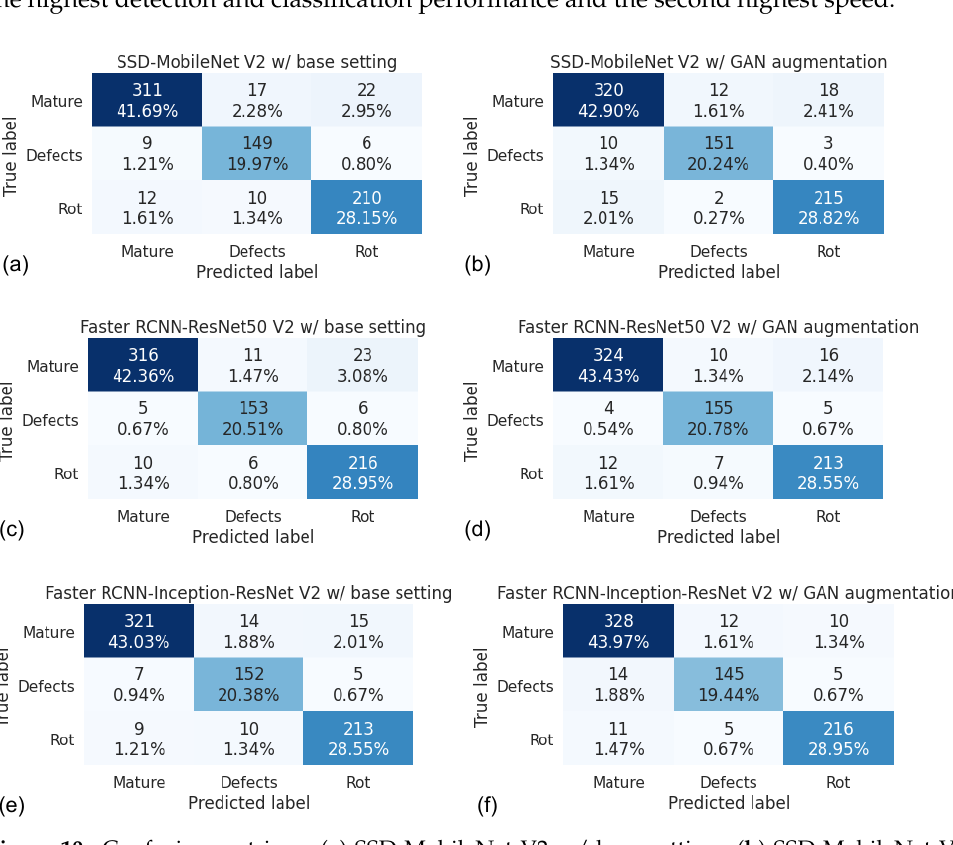
Figure 10. Confusion matrices. ( a ) SSD-MobileNet V2 w/ base setting. ( b ) SSD-MobileNet V2 w/ GAN augmentation. ( c ) Faster RCNN-ResNet50 w/ base setting. ( d ) Faster RCNN-ResNet50 w/ GAN augmentation. ( e ) Faster RCNN-Inception-ResNet V2 w/ base setting. ( f ) Faster RCNN- Inception-ResNet V2 w/ GAN